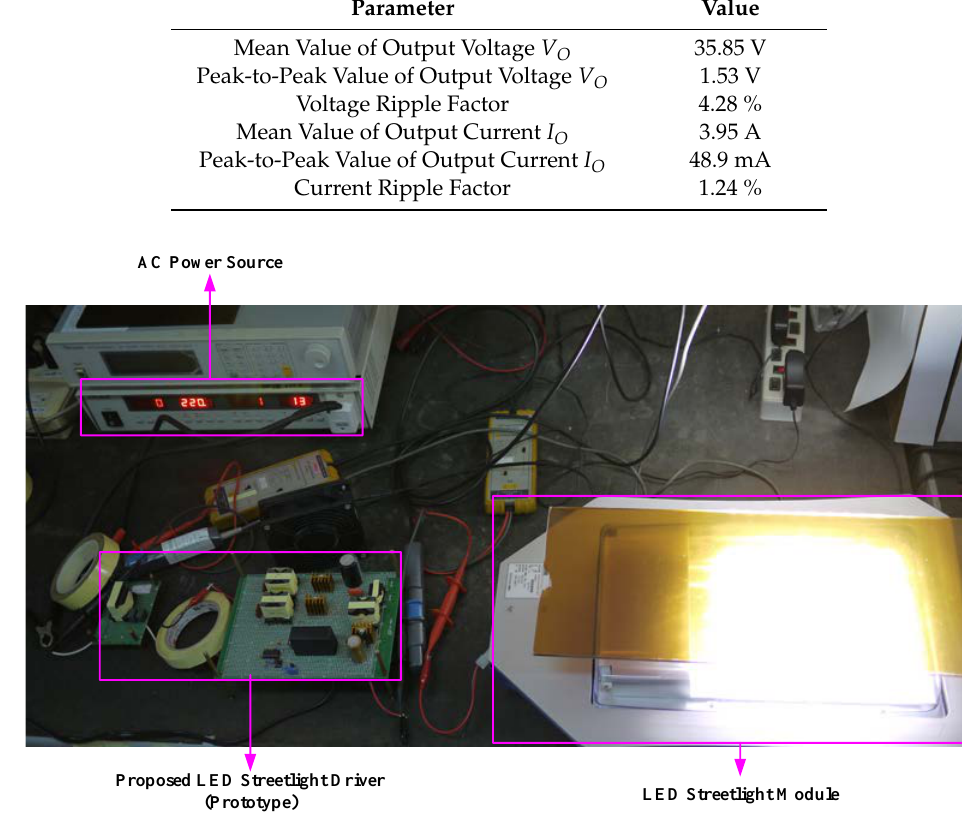
Figure 15. Photo of supplying the LED streetlight module with the proposed streetlight driver at a input utility-line voltage of 220V.